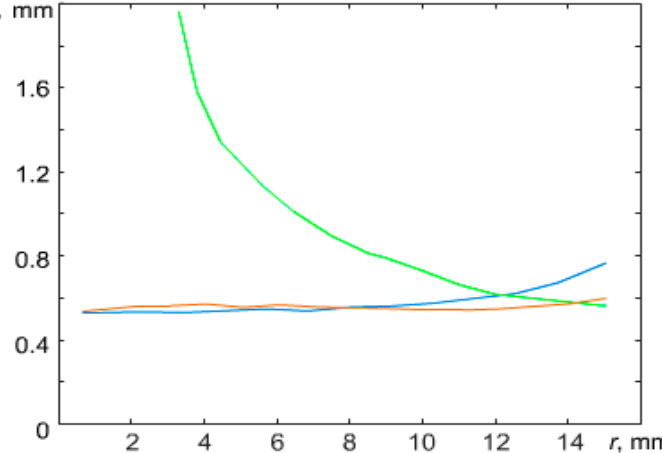
Figure 5. A dependence of the radial distribution of the average interparticle distance in the quasi- two-dimensional structure in an argon plasma of RF discharge at W = 13.1 W and various values of argon pressure P: (a) blue curve is for 3 Pa, (b) red is for 4 Pa, (c) green is for 5